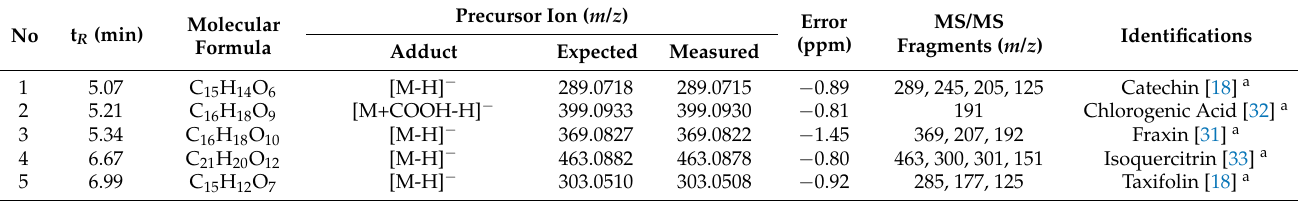
Table 1. Identification of phytochemicals in Q. acuta by UPLC-MS/MS